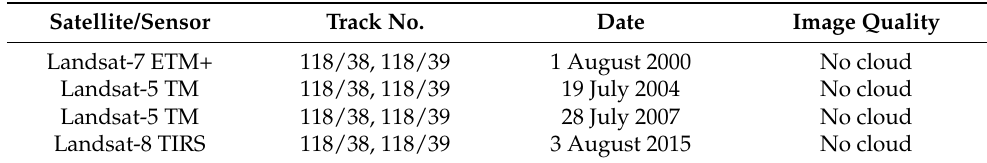
Table 2. Data: date and weather information. Satellite/Sensor Track No. Date Image Quality